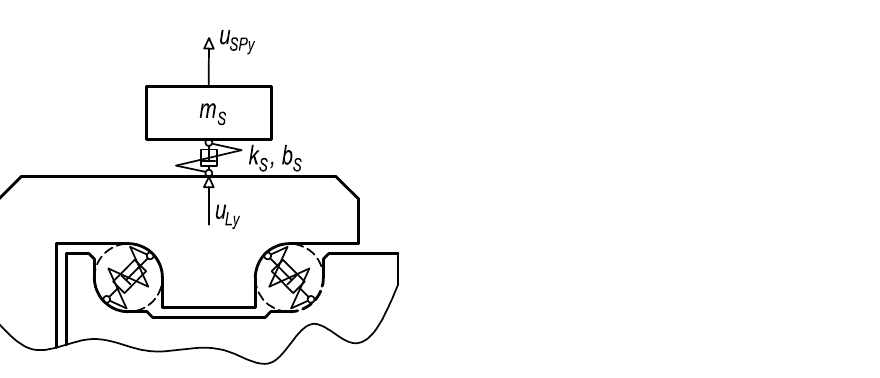
Figure 13. The mechanical model of the sensor connected via rubber spring and additional weight.